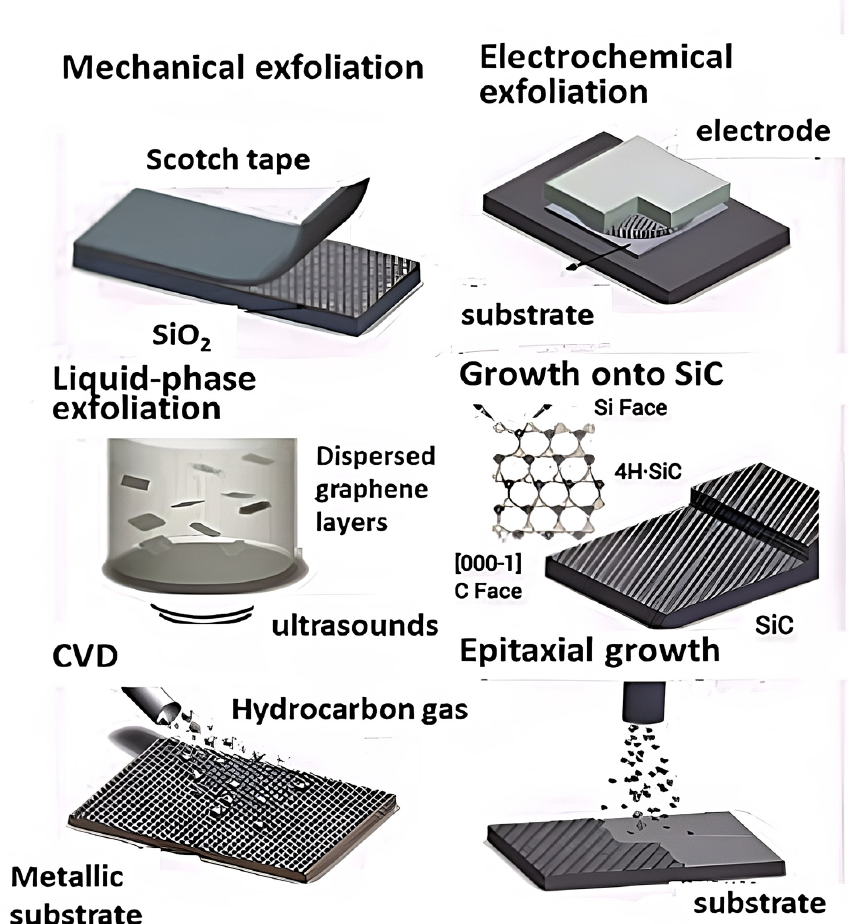
Figure 6. Top-down and bottom-up techniques for graphene synthesis.